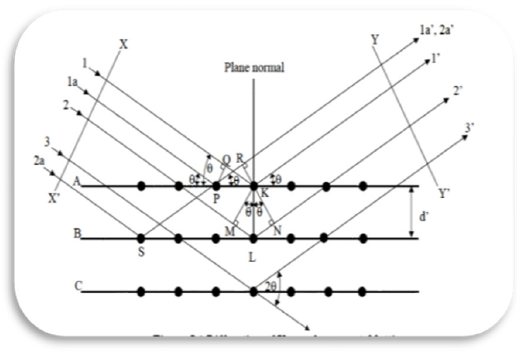
Fig. 2. Residual stress measurement